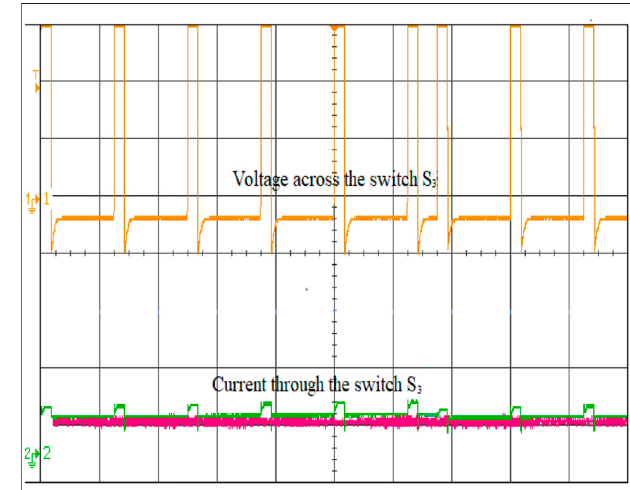
FIGURE 11 | Characteristics of switch S 3 .